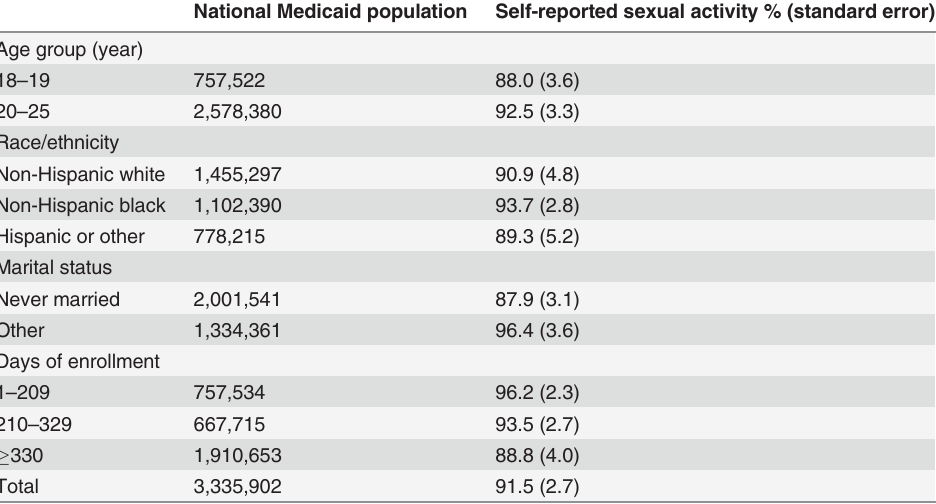
Table 1. Demographics and enrollment of linked Medicaid women aged 18 – 25 years (N = 338), 2001 –